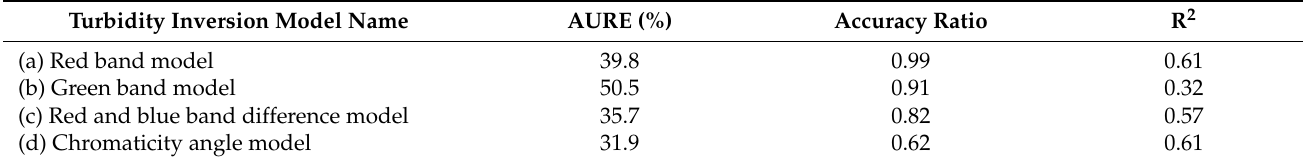
Table 6. Turbidity model accuracy